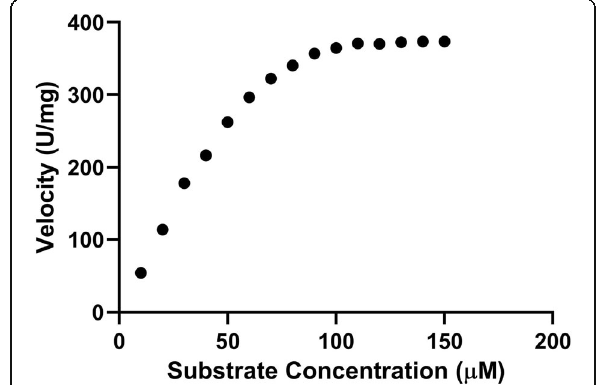
Fig. 3 Effect of substrate concentration on proteolytic activity upon casein as